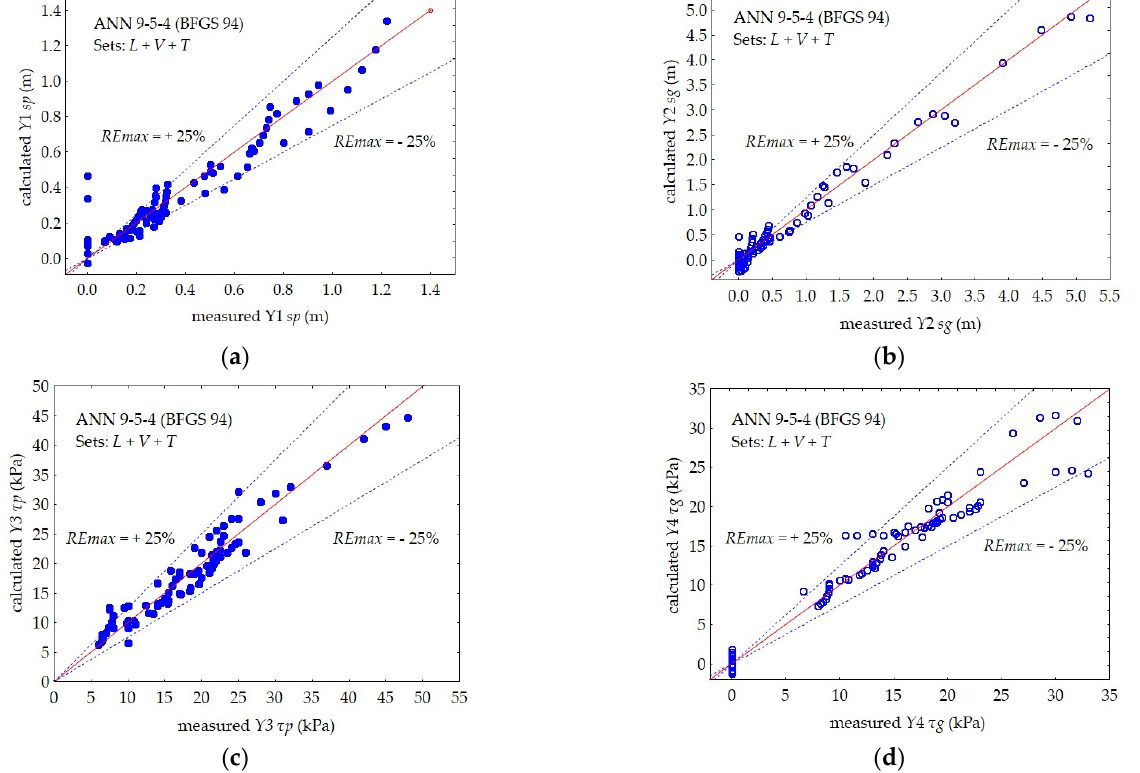
Figure 10. Comparison between the measured and calculated values by ANN 9–5–4 in subsets L + V + T : ( a ) Y 1 sp , ( b ) Y 2 sg , ( c ) Y 3 τ p , and ( d ) Y 4 τ g .